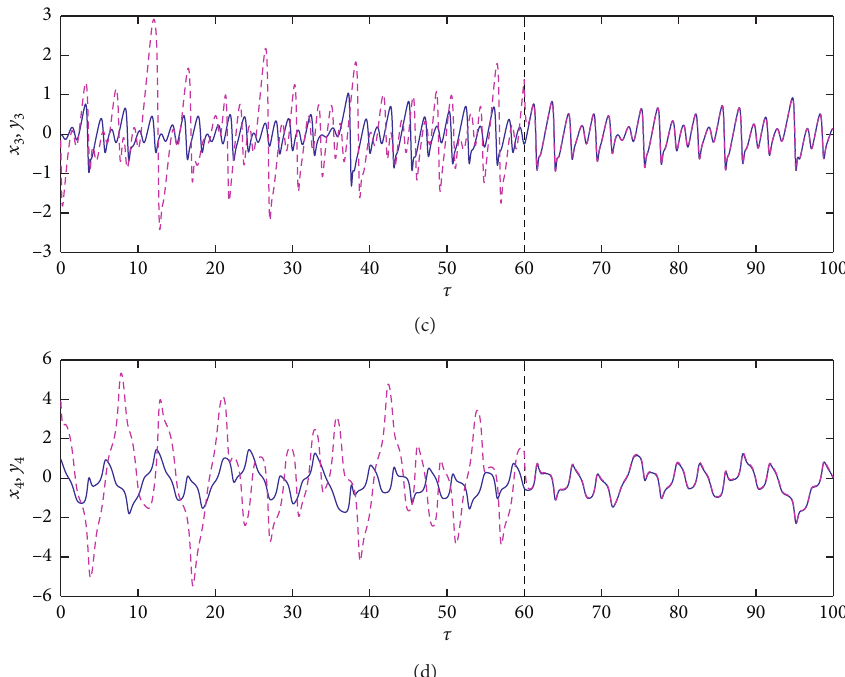
Figure 20: Time series x